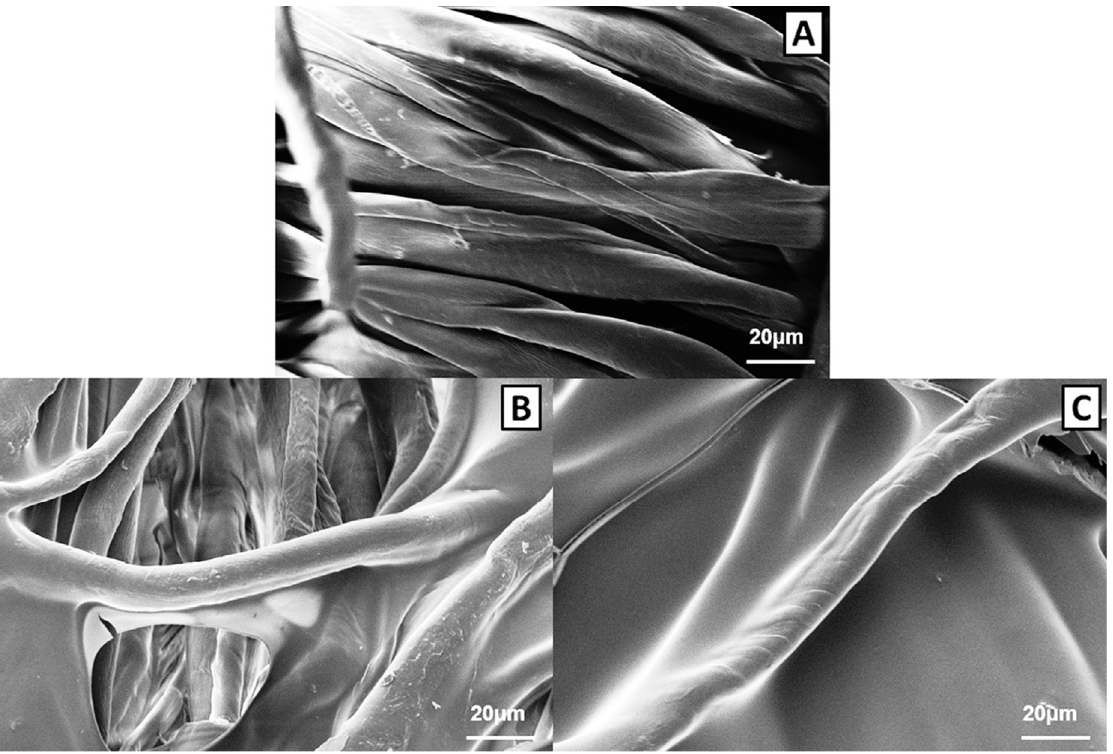
Figure 4. SEM magnifications of untreated cotton ( A ), cotton treated with caseins ( B ) and cotton treated with hydrophobins ( C ). Reproduced with permission from [38]. Copyright 2014, Elsevier. Table 6. Results from thermogravimetric analyses for untreated (COT) and hydrophobin-treated (COT-H) cotton fabrics.